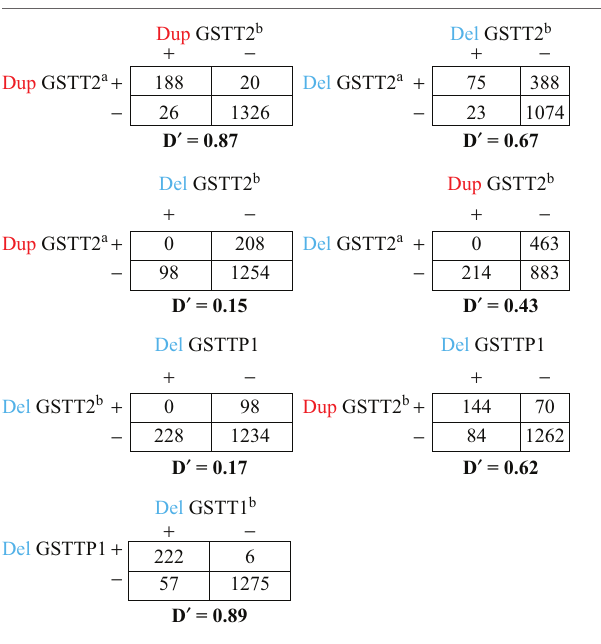
Table A1 | Cross-tabulation and linkage disequilibrium of CNVs in GSTT1/GSTT2 region. Duplication (Dup) or deletion (Del) is present ( + ) or absent ( −